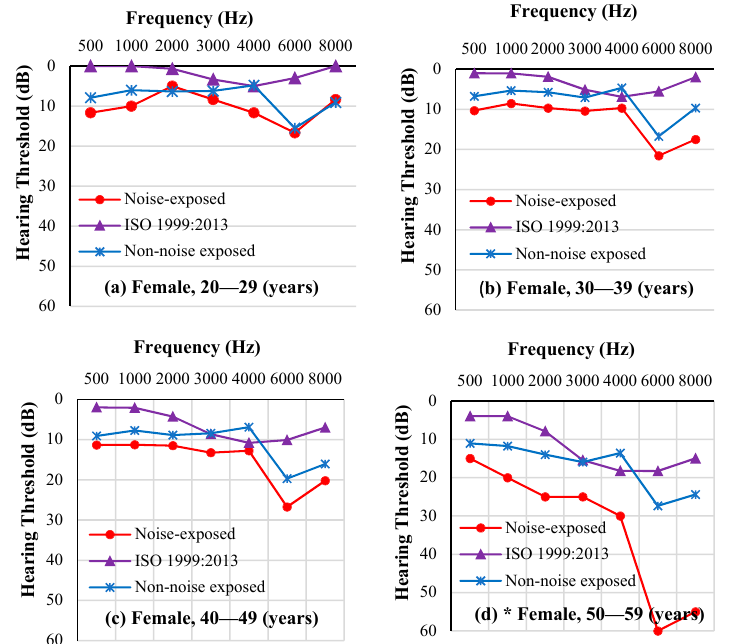
exposed male workers by frequency and age group. male workers by frequency and age group.